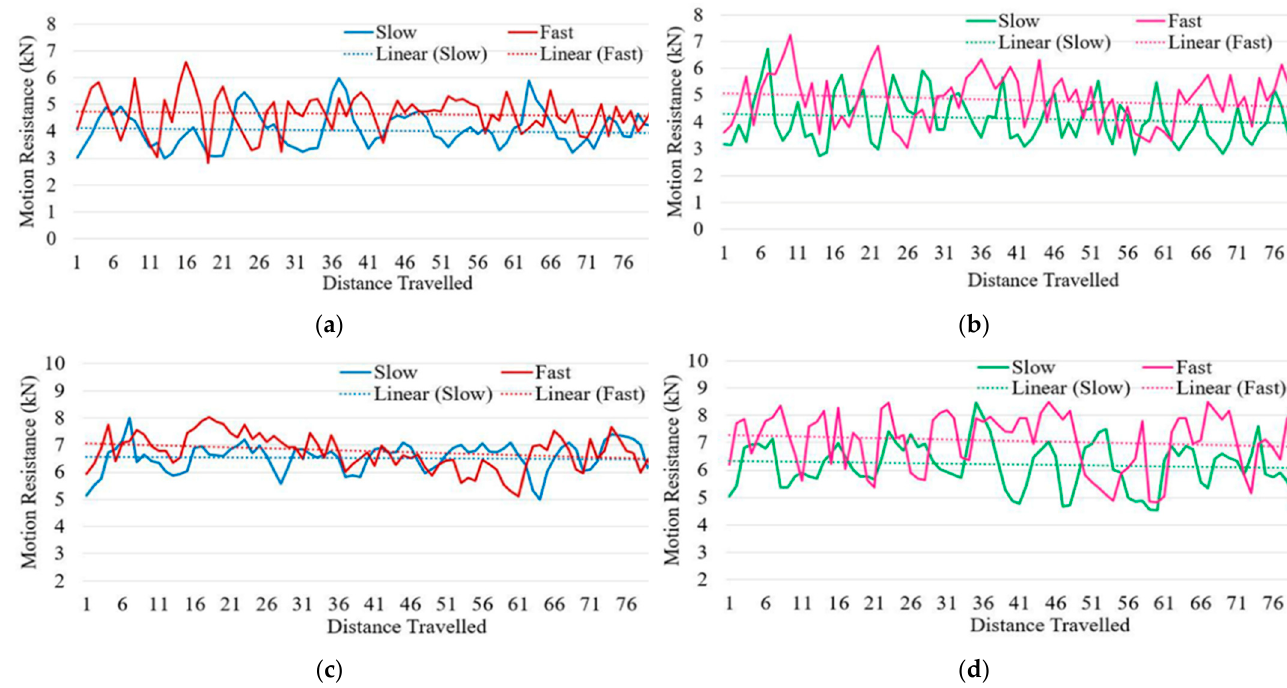
Figure 4. Motion Resistance of both traction wheels in different field conditions and speed treatments; CTW ( a ) tilled field, ( b ) untilled field and RLW ( c ) tilled field, ( d ) untilled field.